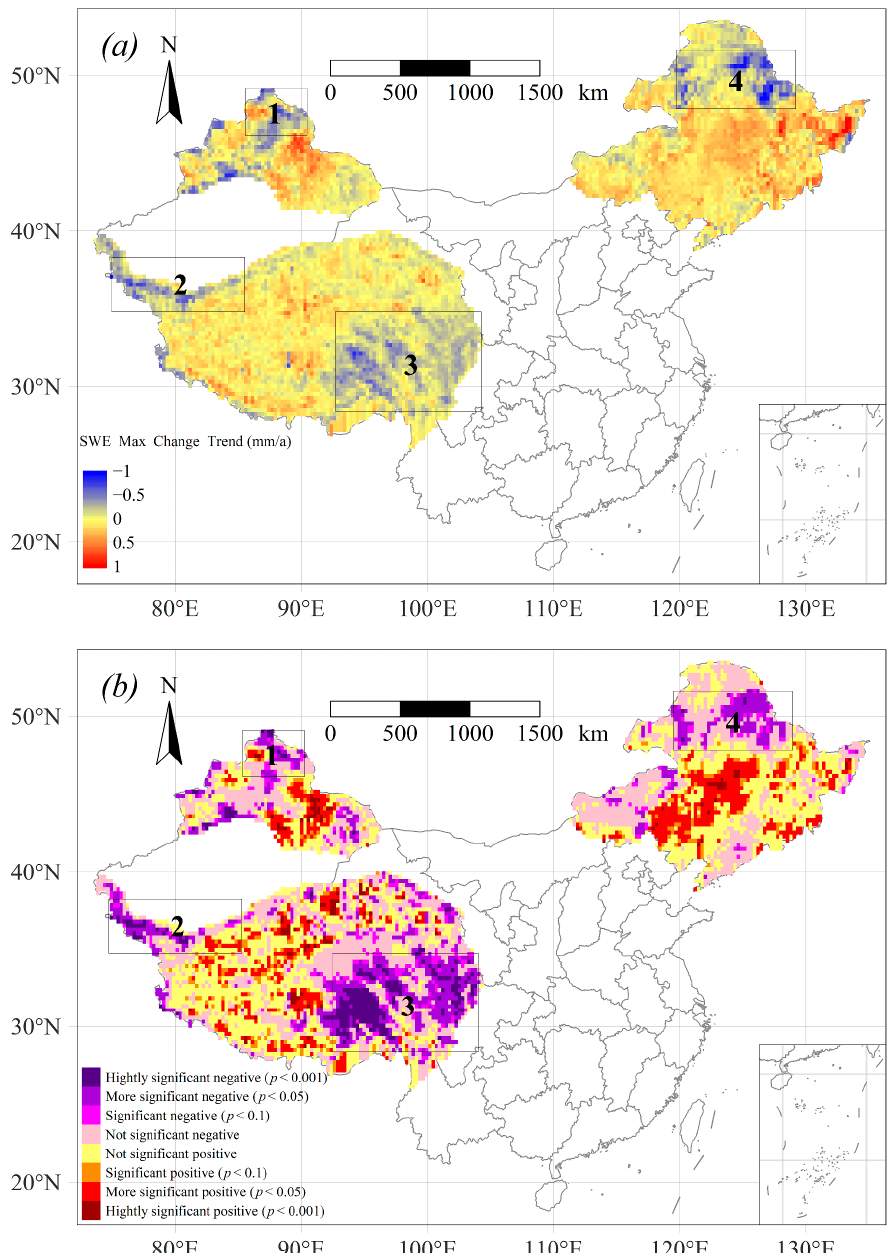
Figure 2. Spatial variation in the ( a ) annual maximum SWE (snow water equivalent) and ( b ) corre- sponding significance levels ( t -test) for the trends over the past 40 years (1981–2020) across the three main stable snow cover regions of China. The unit mm/a refers to mm per year.